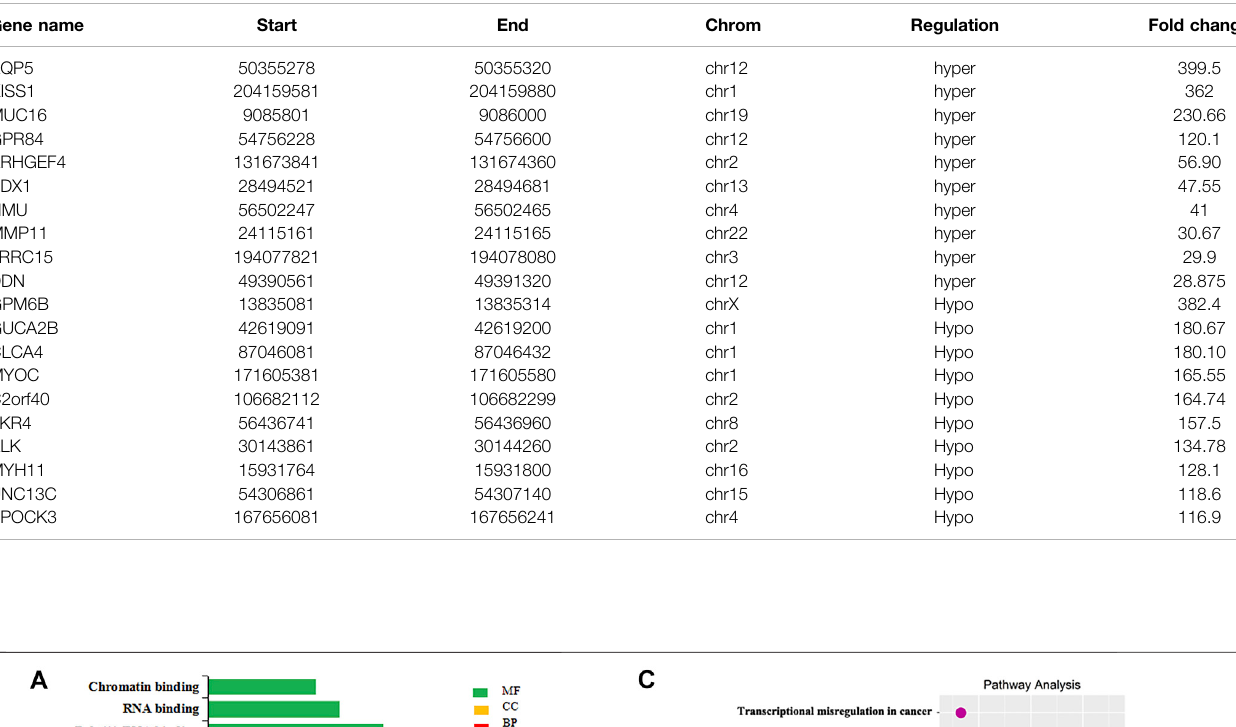
TABLE 1 | The top 10 genes of m 6 A hypermethylated or hypomethylated.